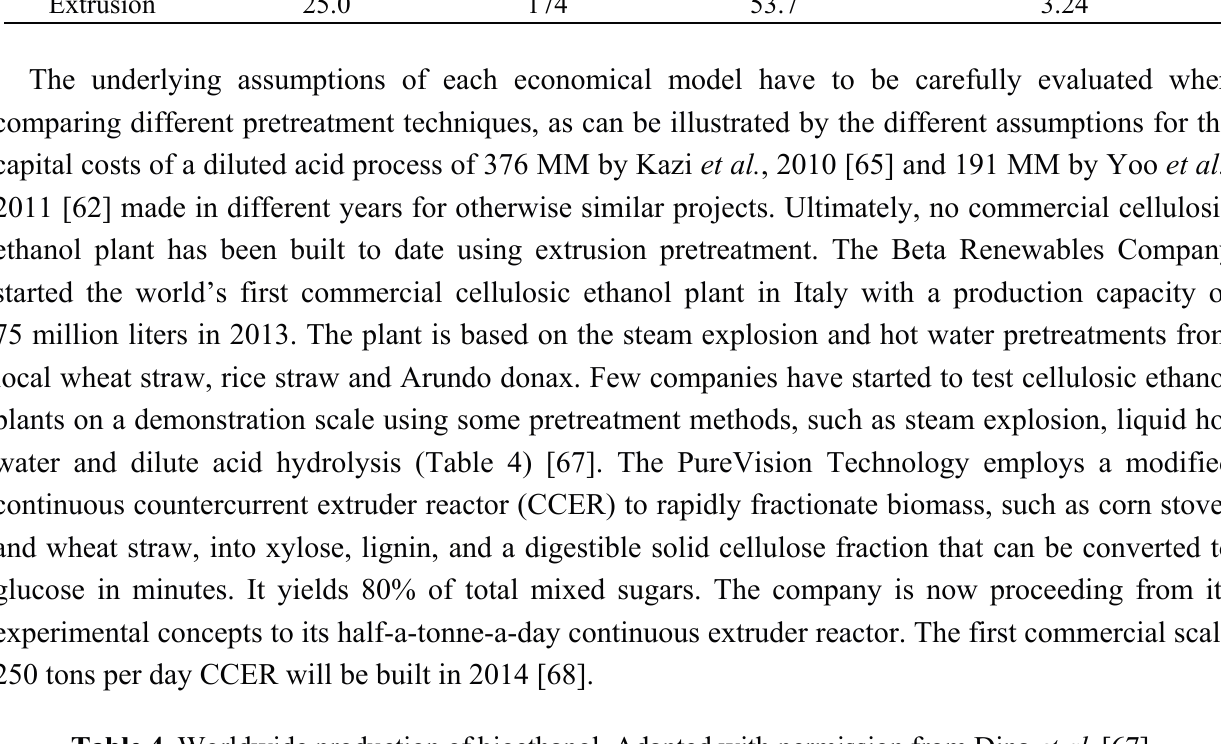
Table 4. Worldwide production of bioethanol. Adapted with permission from Dina et al. [67].